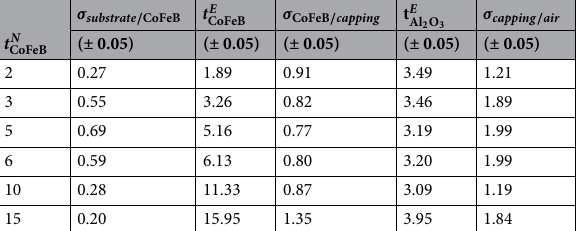
t E CoFeB ) from XRR analysis. The